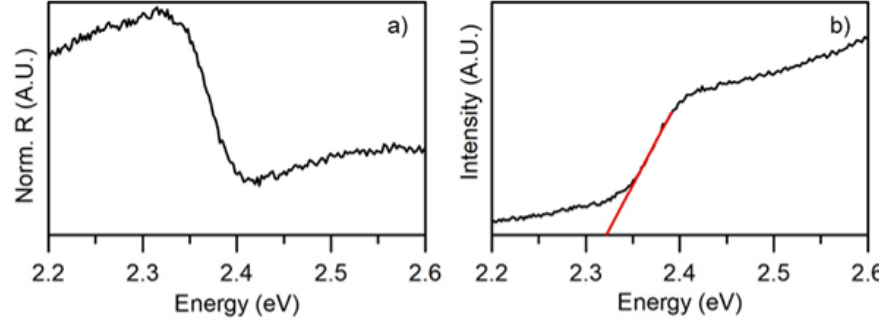
Figure 8. ( a ) Diffuse reflectance spectrum of the magnetron sputtered thin film on glass and ( b ) Band gap of the thin film calculated from absorbance data using the Tauc